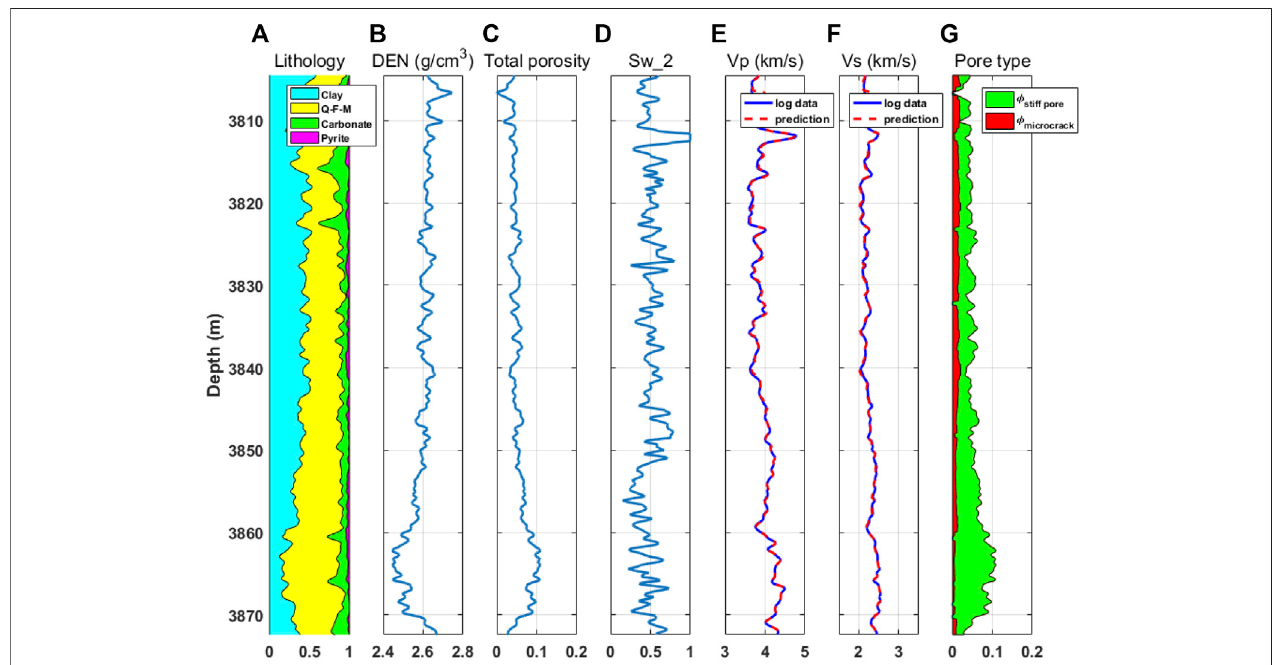
FIGURE 2 | The logging data of the target section in Well-Y1 (this corresponds to the bottom part of the logging data in Figure 1 ): (A) mineral components; (B) density; (C) totalporosity; (D) watersaturationevaluatedbasedonneutron-densitymethod; (E) measuredandpredictedP-wavevelocities; (F) measuredandpredicted S-wave velocities; (G) porosities of microracks and stiff